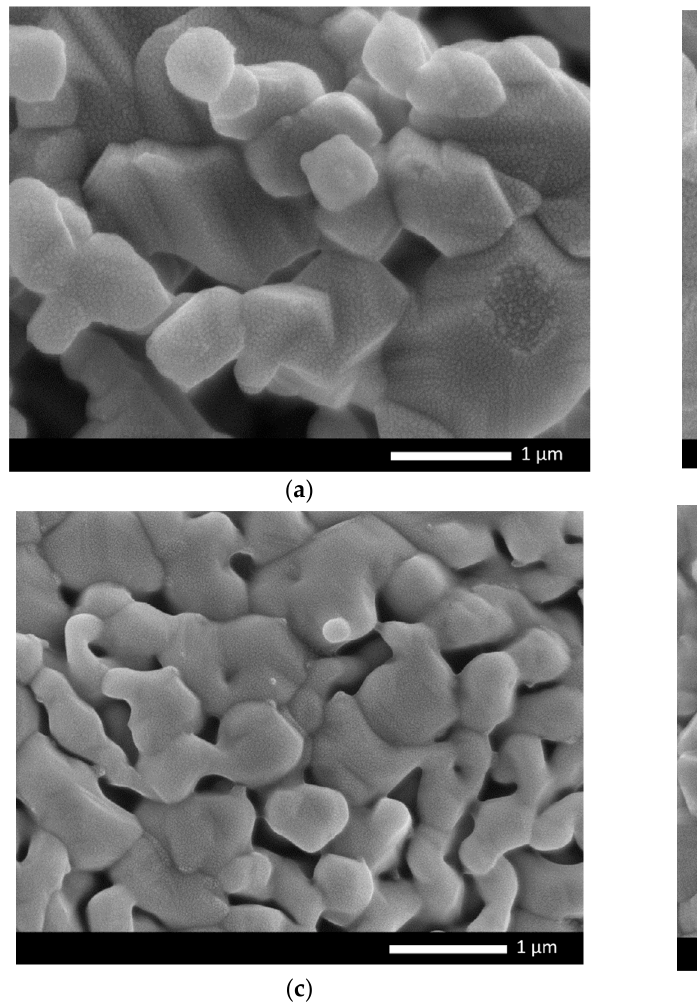
Figure 2. SEM images of synthesized perovskite ‐ like powders as a function of La concentration: ( a ) 0.10 mol; ( b ) 0.15 mol; ( c ) 0.20 mol; ( d ) 0.25 mol.